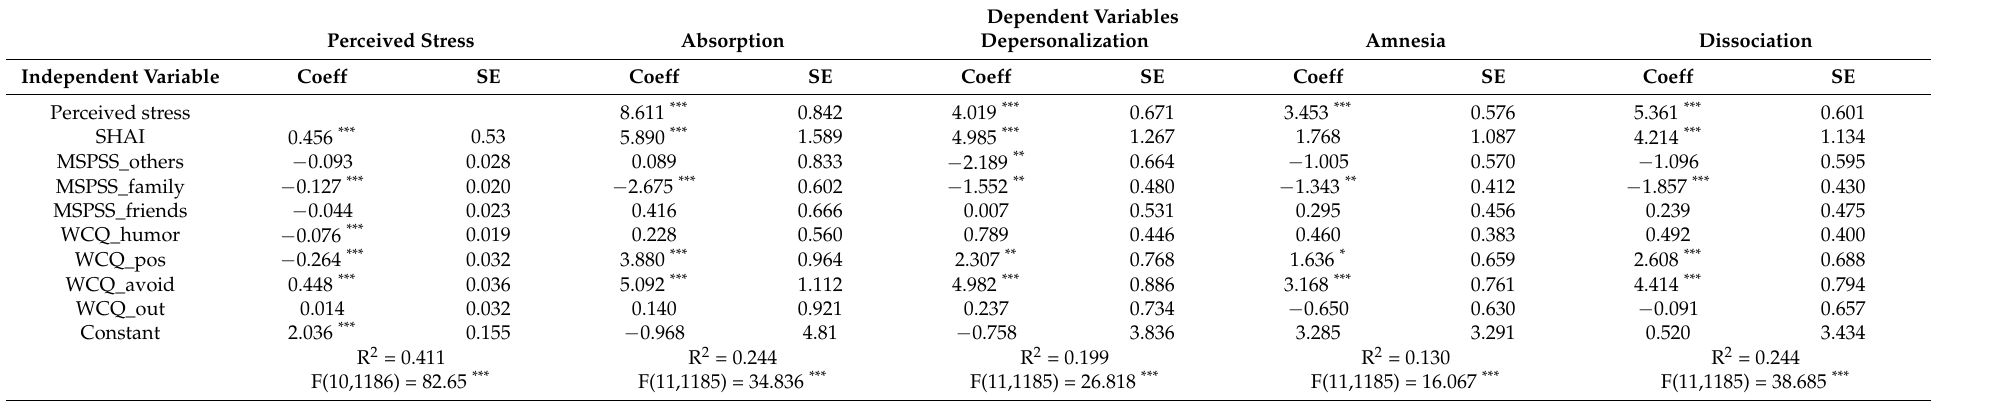
Table 8. Coefficients of the linear regression of the Hungarian sample.